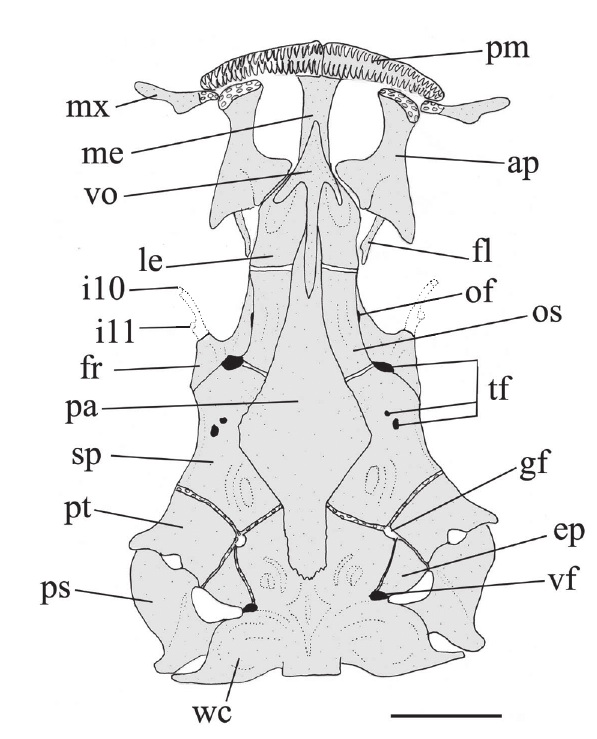
Fig. 2. Neurocranium and Weberian apparatus of Trichomycterus payaya , UFBA 5286, paratype, 31.4 mm SL. Dorsal view. Abbreviations: af, anterior fontanel; ao, lacrimal; ap, autopalatine; ep, epioccipital; fl, fronto- lacrimal tendon bone; fr, frontal; i10, i11, infraorbital sensory pores 10 to 11; le, lateral ethmoid; me, mesethmoid; mx, maxilla; pf, posterior fontanel; pm, premaxilla; ps, posttemporo supracleitrum; pt, pterotic; p1, p2, postotic sensory pores 1 to 2; so, parieto-supraoccipital; sp, sphenotic; s1, s3, s6, supraorbital sensory pores 1 to 6; wc, weberian complex and capsule. Scale bar = 1 mm.